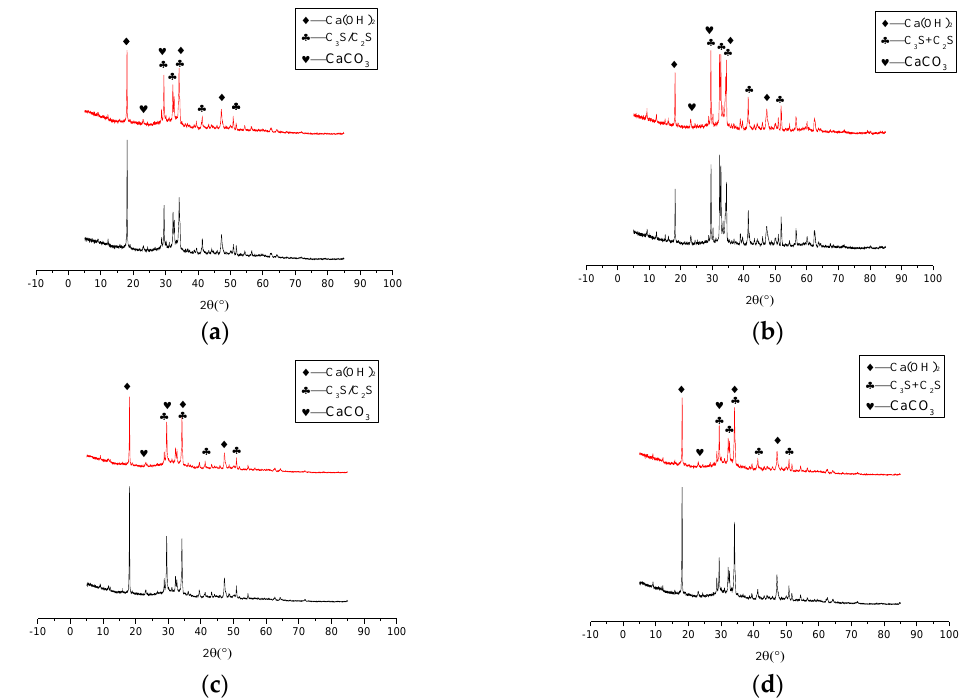
Figure 8. XRD patterns of cement pastes with 3% or without of nano-SiO 2 at different ages: ( a ) one day; ( b ) three days; ( c ) seven days; and ( d ) 28 days. Table 9. Peak intensity of Ca(OH) 2 and C 3 S of samples with or without nano-SiO 2 .